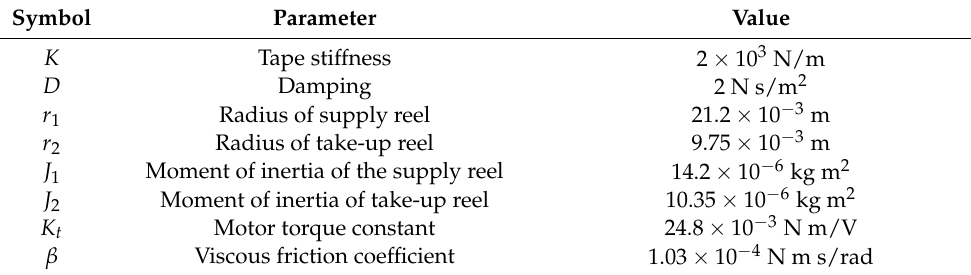
Table 2. Tape transport system